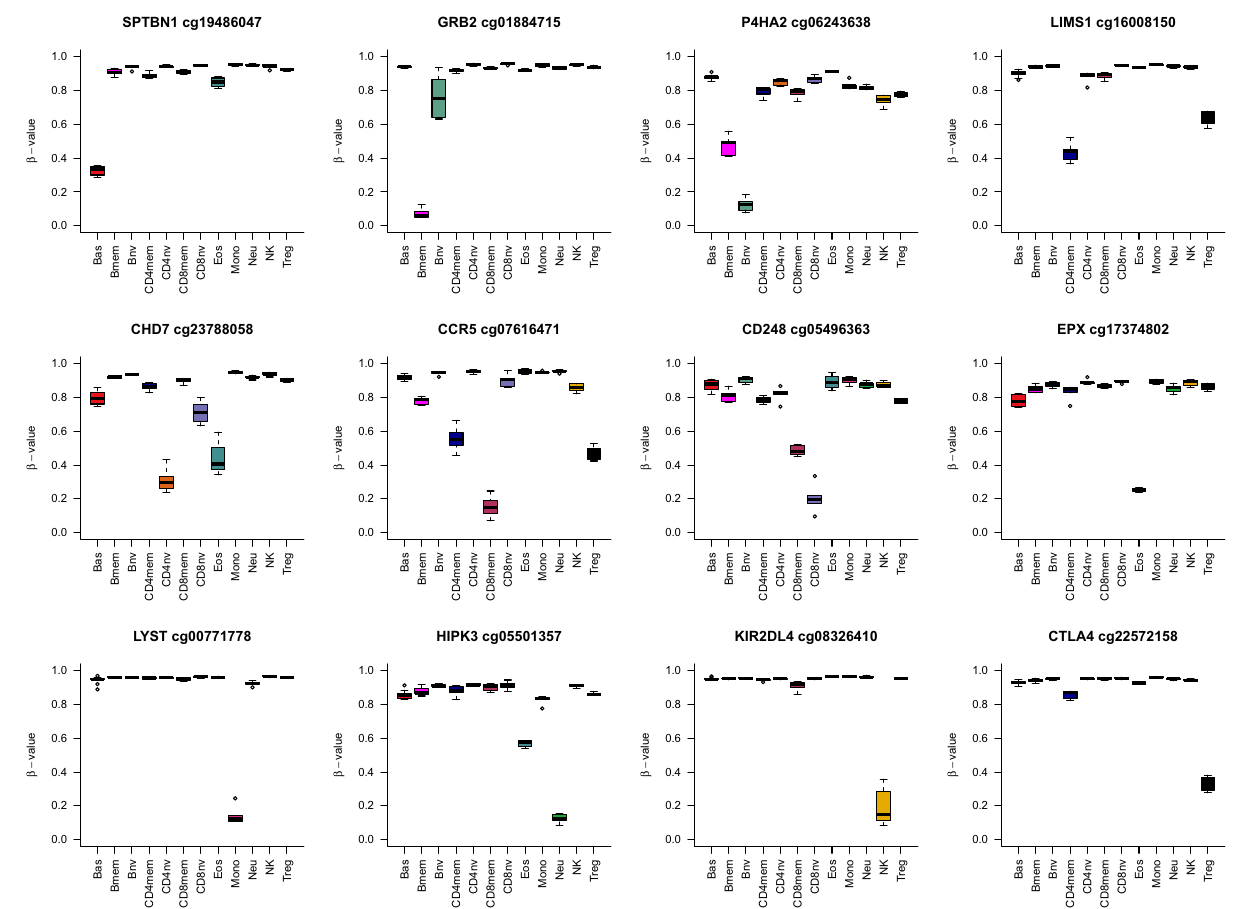
Fig. 5 Examples of differentially methylated sites demarcating the different cell lineages. The boxplots include the following information: (1) The box shows the interquartile range (IQR), (2) the whiskers show the inner fences (1.5 × IQR out of the box), (3) the bolded line shows the median of the data. The color inside the box corresponds to the cell type. Source data are provided as a Source Data fi le. Bas Basophils, Eos eosinophils, Neu neutrophils, Bnv B-cells naïve, Bmem B-cells memory, CD4nv helper CD4( + ) T-cells naïve, CD4mem helper CD4( + ) T-cells memory, Treg CD4( + ) T regulatory cells, CD8nv cytotoxic CD8( + ) T-cells naïve, CD8mem cytotoxic CD8( + ) T-cells memory, Mono monocytes, NK natural killer